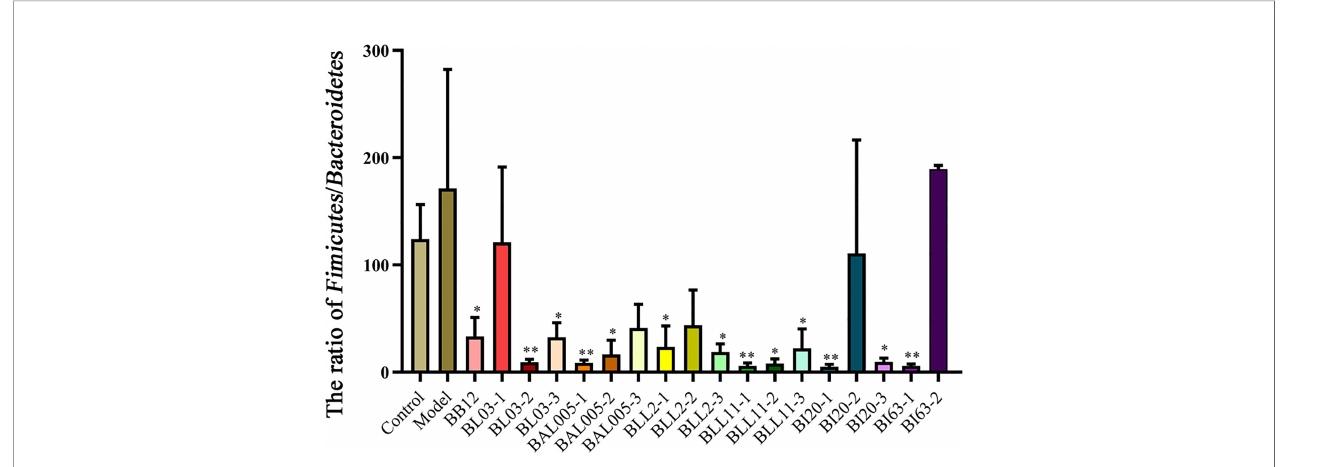
FIGURE 8 | The ratio of Firmicutes / Bacteroidetes in mice treated with different embedding methods. There is a signi fi cant difference between the bacterial intervention group and the model group, where * means P < 0.05, **P < 0.01.